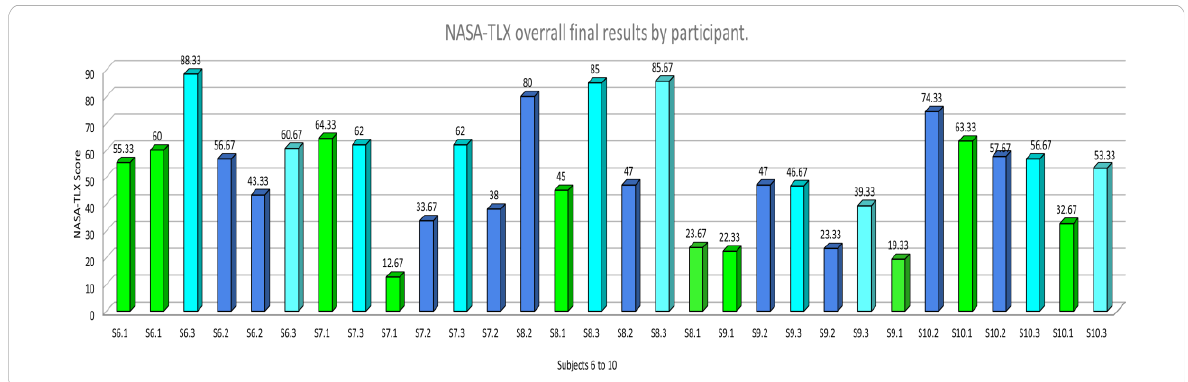
Figure 6. NASA-TLX overall results Subjects 1 to 5.